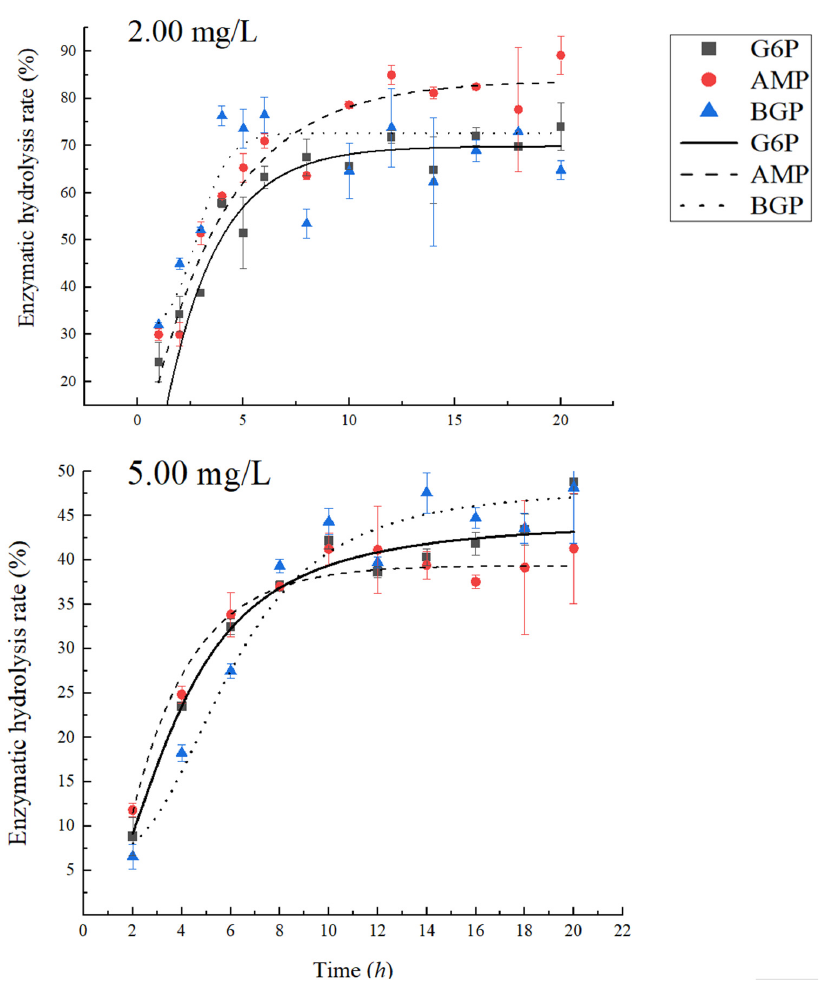
Figure 2. The reaction time of PhoA to mineralize organic phosphorus at the initial concentrations of 2.00 mg/L and 5.00 mg/L. Lines in the figures refer to the fitting curves of different reactive time.